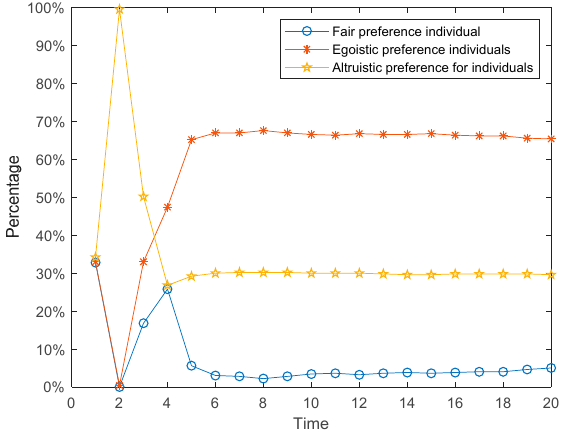
Figure 24. Individual proportions with three different preferences changing over time.